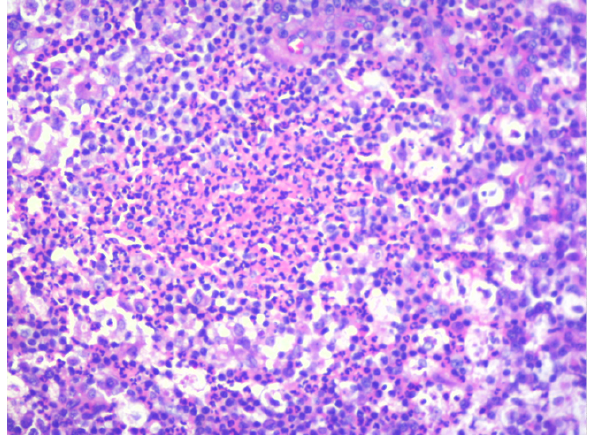
Figure 2: Histopathological examination showing polymorphs and neutrophilic